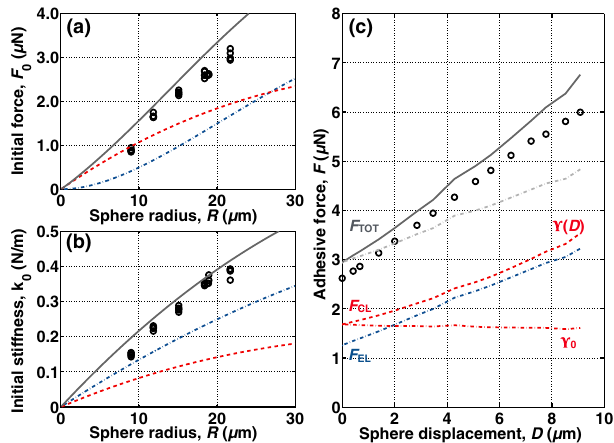
FIG. 3. Predicting adhesive forces. (a,b) Initial force F 0 and initial contact stiffness k 0 , respectively, vs sphere radius R . Plotted are measured data (black symbols), predictions of elastic theory (blue dot-dashed lines) [17], and capillary force predic- tions accounting for a strain-dependent surface stress (red dashed lines). Solid gray lines show the sum of the capillary and elastic predictions. (c) Measured force vs sphere displacement for an example experiment using an 18 . 9 - μ m-radius sphere (black points). Theoretical predictions are overlaid as follows: elastic theory (blue dot-dashed line), capillary prediction with constant or strain-dependent surface stress (red dot-dashed line and red dashed line, respectively), and total estimated force with constant or strain-dependent surface stress (gray dot-dashed line and solid gray line,